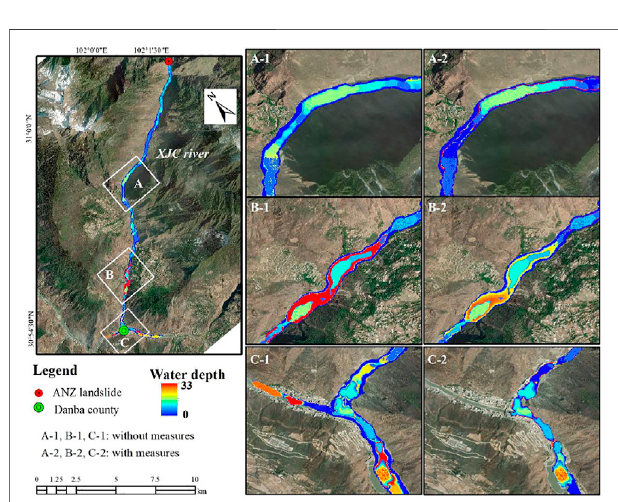
FIGURE 9 | Spatial distribution of the computed maximum fl ow depth. A-1, B-1, C-1: without engineering measures, A-2, B-2, C-2: with engineering